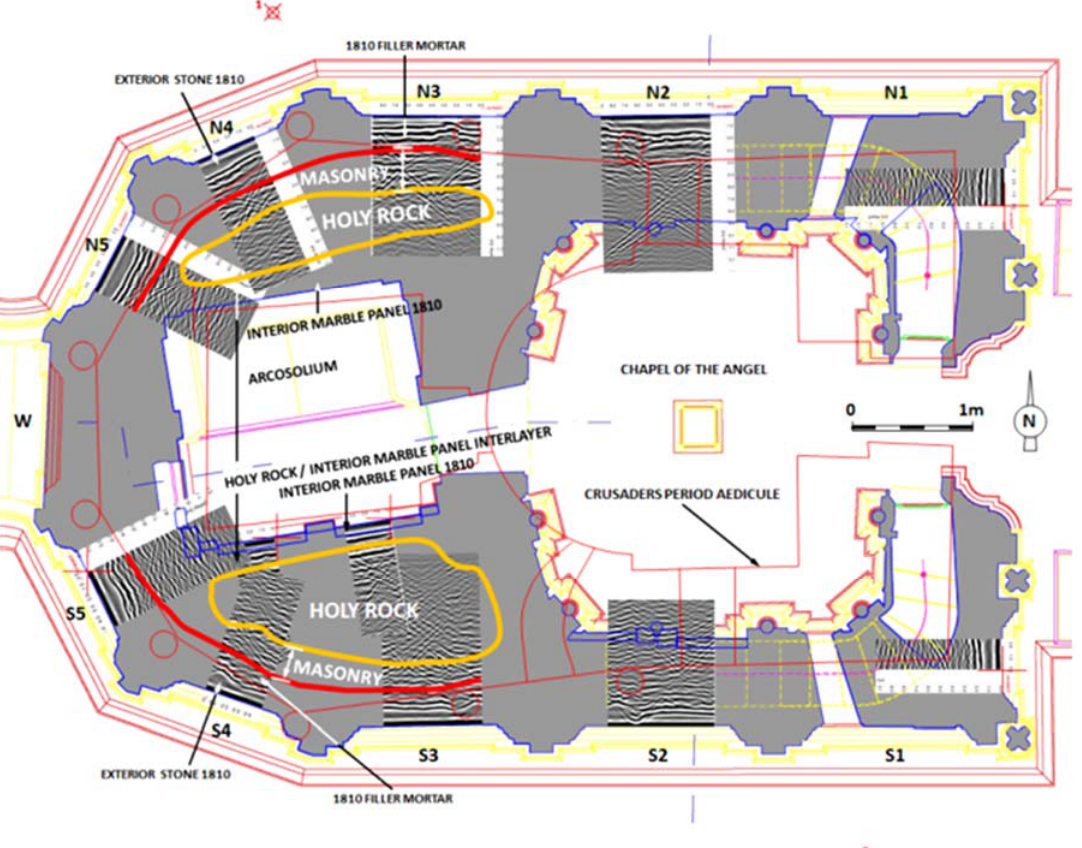
Figure 3: Overlay (layer height 130cm) of data processed GPR scans on the plan of the Holy Aedicule, and identification of the construction layers of the structure. The red outline of the Crusaders’ period Aedicule is also indicated in the plan.